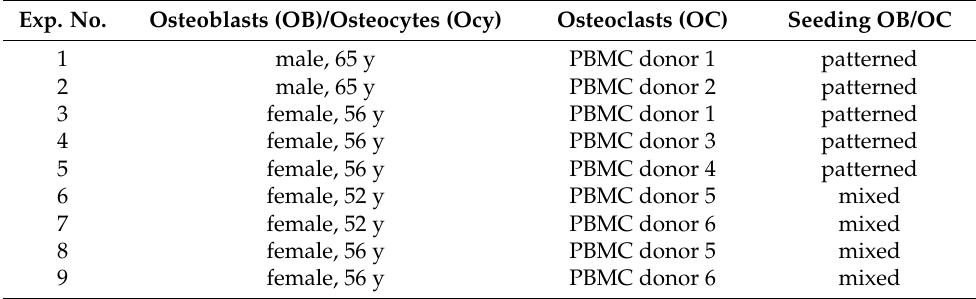
Table 1. Donors and combination of cells for the different triple co-culture experiments. Exp.